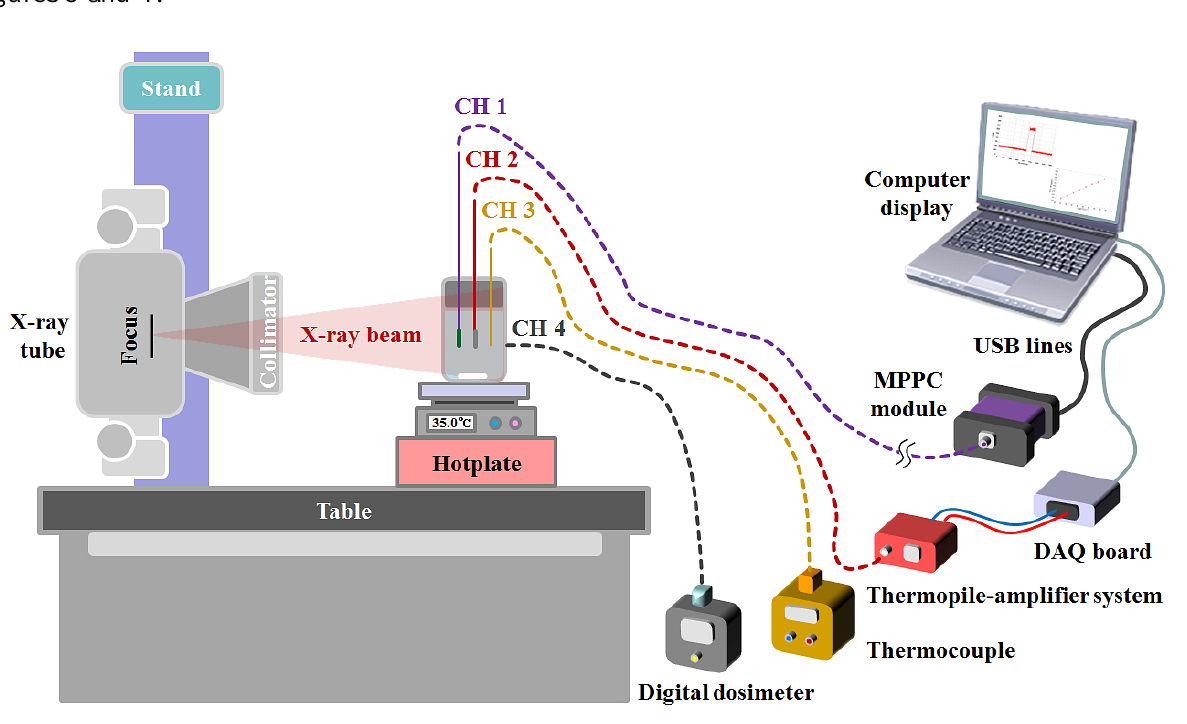
Figure 3. Whole experimental setup using a DR system and a